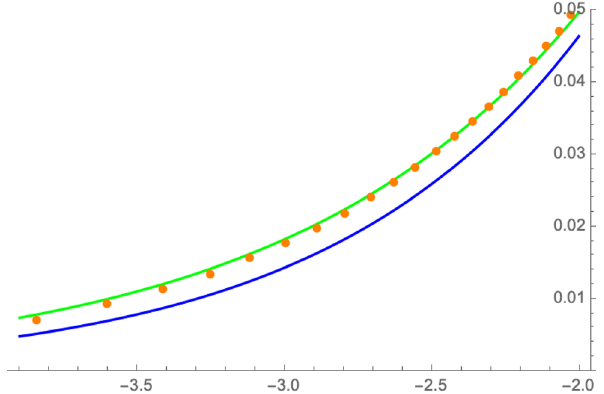
Figure 7 . Eigenvalue density for SU( N/ 2) , N/ 2 = 500 , on the tail. The orange dots are the N/ 2 numerical result while the green curve is the approximate density ρ ( σ ) = e σ − 1 . The blue curve is the fit shown in figure